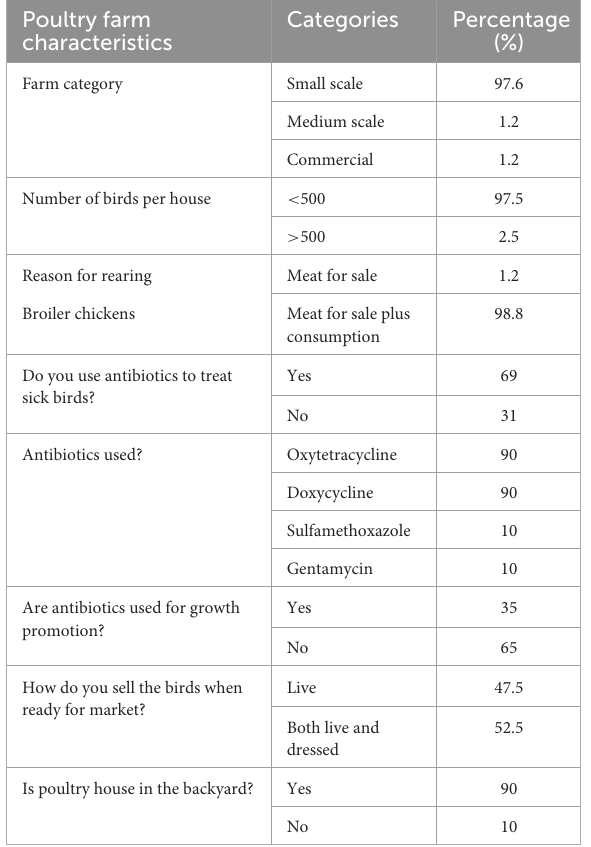
TABLE 2 Poultry farm characteristics and antibiotics use ( N = 80). Poultry farm